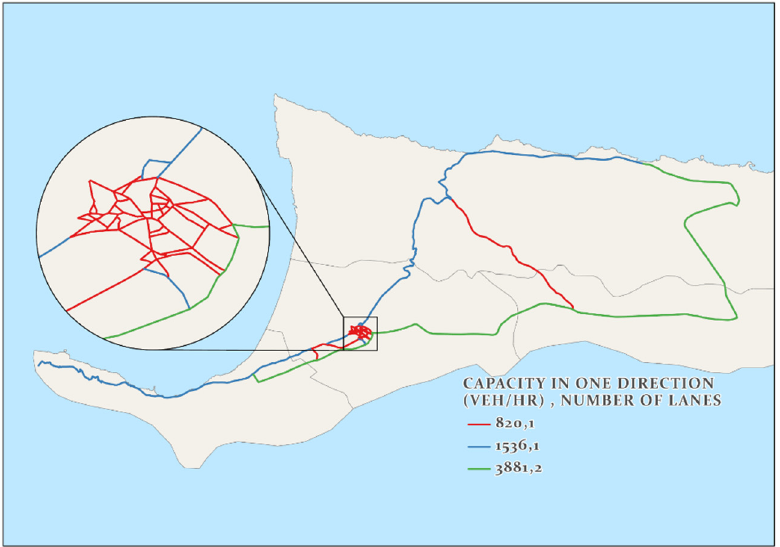
Figure 6. Transportation network link capacity distribution.